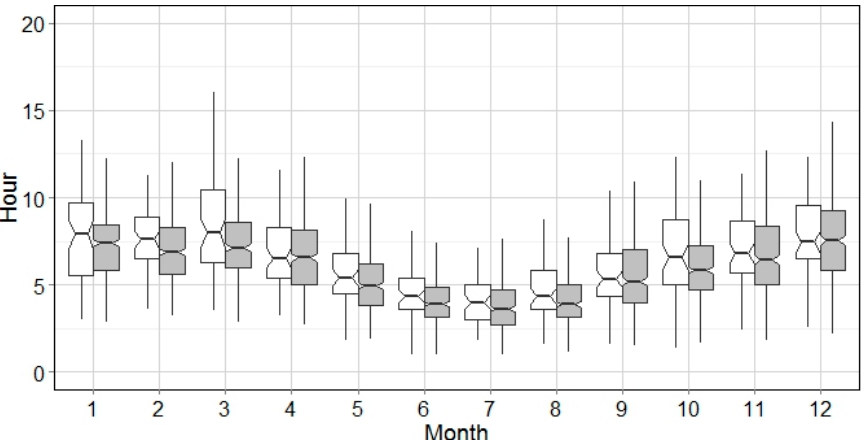
Figure 4. Boxplots of Wet Event Duration (WED) means (Historical: White, Synthetic: Grey).